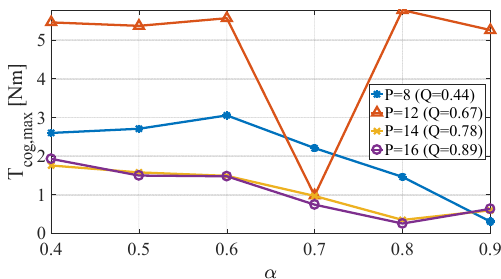
ff erent pole spans α